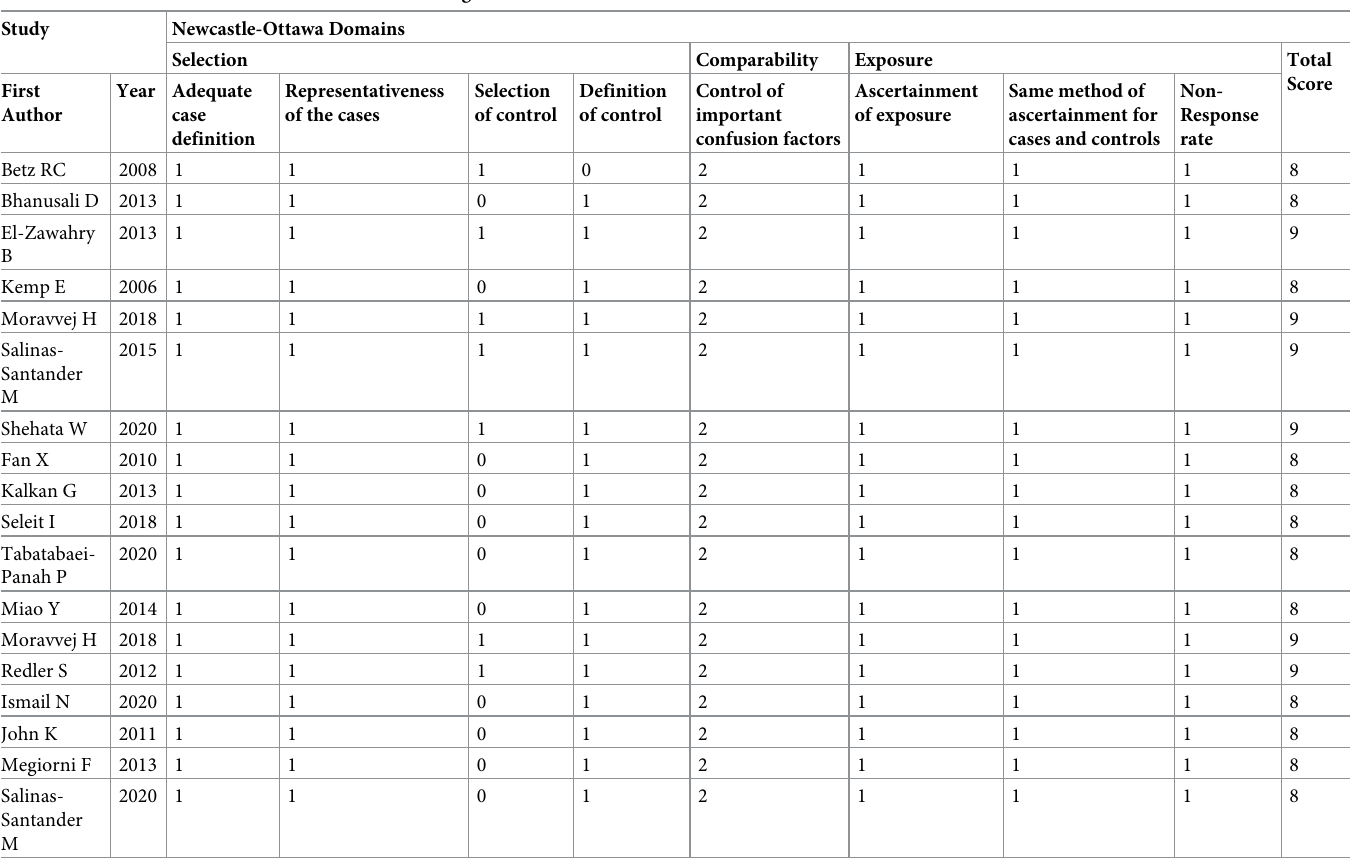
Table 2. Risk of evaluation bias of included studies using the Newcastle-Ottawa